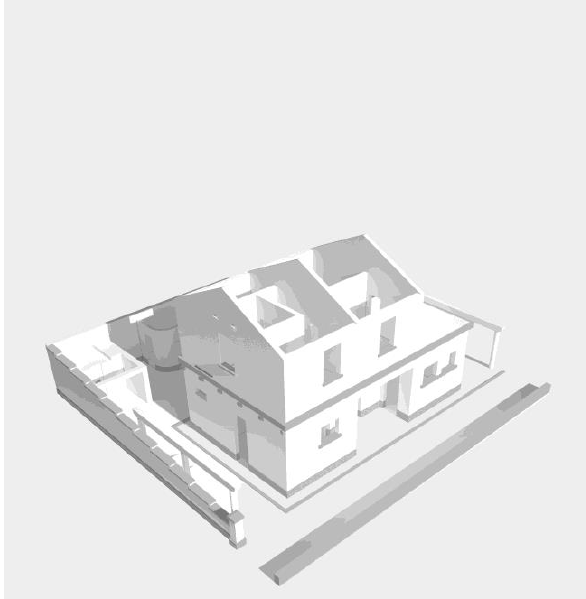
Figure 9. The Royal Park of Tirana. 3D relief of the gardener's